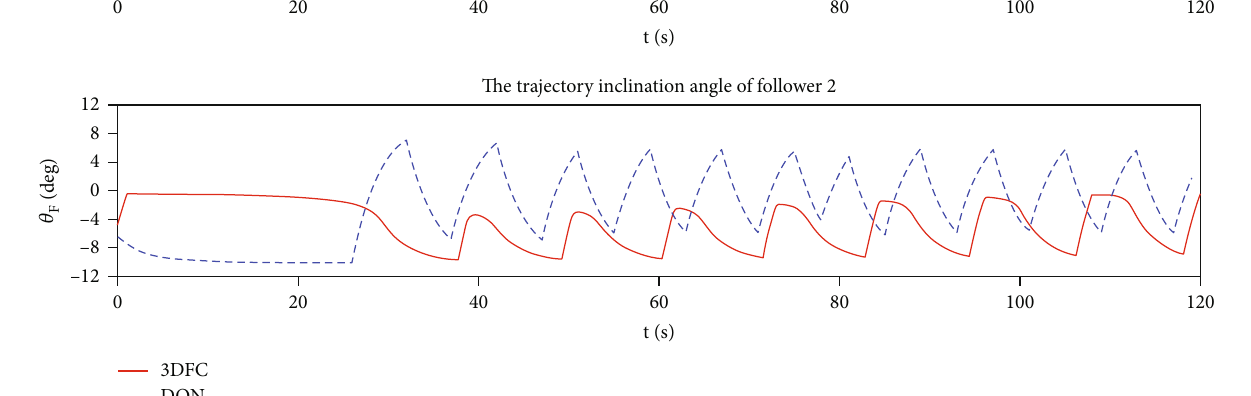
Figure 10: The trajectory inclination angle of the followers.